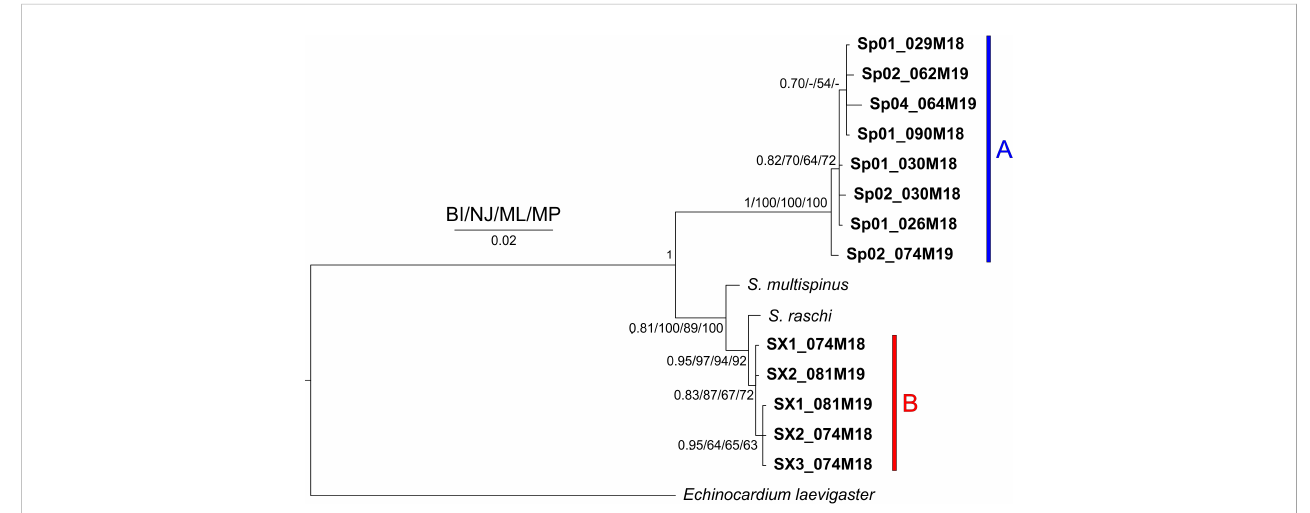
FIGURE 7 Tree obtained with the concatenated 16S and cytochrome c oxidase subunit1 (COI) sequences. Near the nodes are the values for the Bayesian probability (BI) or the bootstrap support (NJ/ML/MP). In bold are the Sardinian spatangids. The bars and capital letters A (blue) and B (red) indicate the sequences of morphotype A and B,